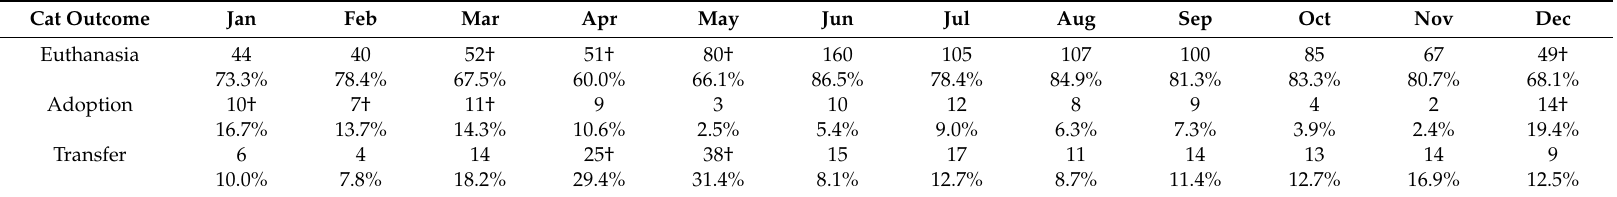
Table 3. Contingency Table for Cat Outcome by Month for Entirely Black Cats ( n =